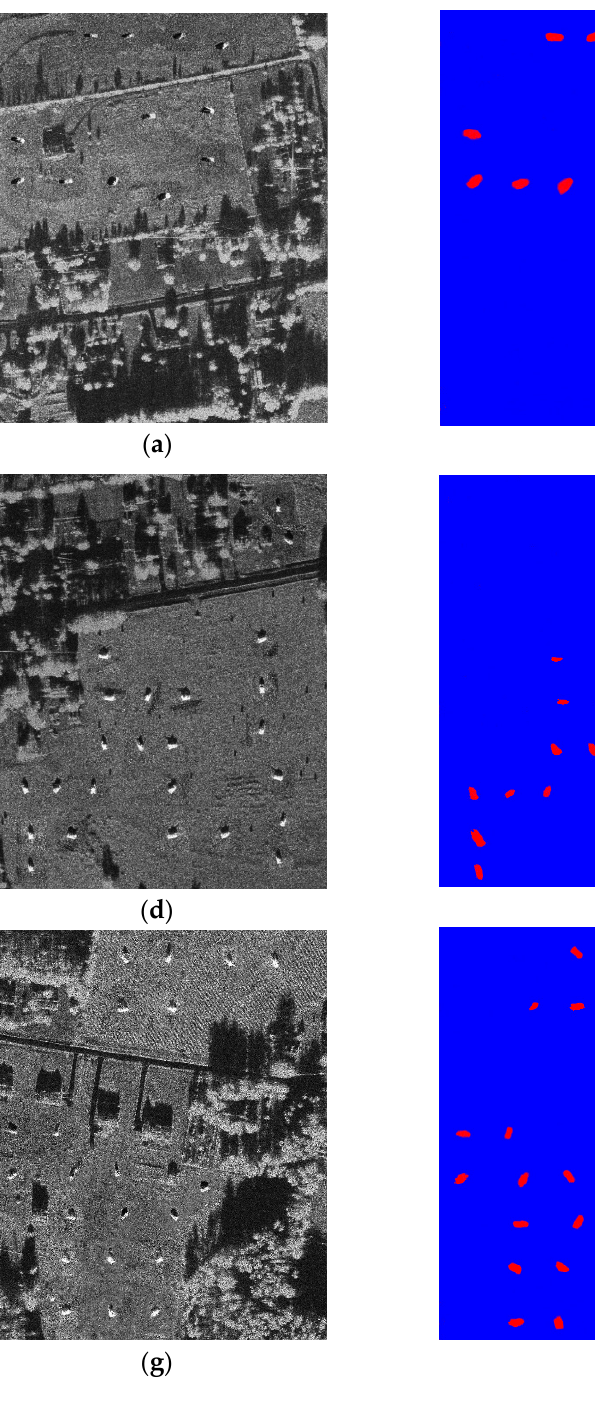
Figure 7. Target detection and recognition results. ( a ) Scene Image 1 containing the target. ( b ) Target detection results. ( c ) Target identification results. ( d ) Scene Image 2 containing the target. ( e ) Target detection results. ( f ) Target identification results. ( g ) Scene Image 3 containing the target. ( h ) Target detection results. ( i ) Target identification results.